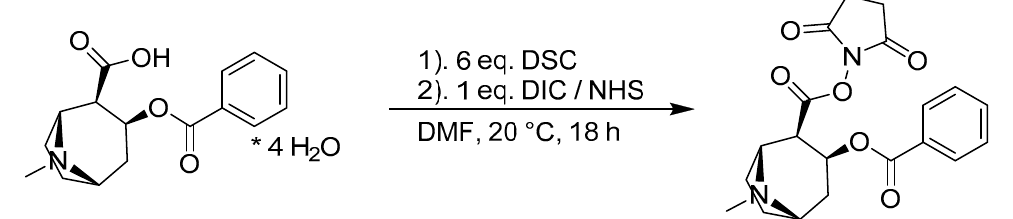
Figure 5. Chemical drying of the benzoylecgonine tetrahydrate (* 4 H 2 O) solution with N,N ′ - disuccinimidylcarbonate (DSC) followed by activation with diisopropylcarbodiimide (DIC) and N-hydroxysuccinimide (NHS) to obtain the BEC-NHS ester.